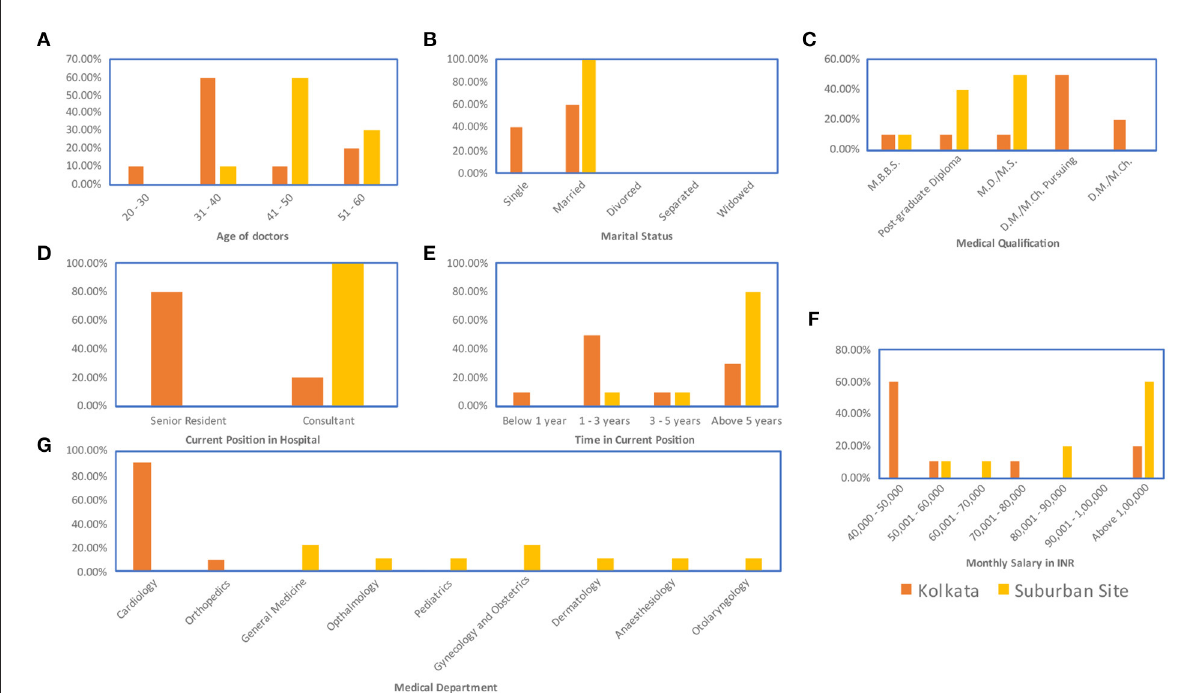
FIGURE1 Demographic data for doctor respondents: (A) Age (B) Marital status (C) Medical qualification. Within the Indian system, medical education is provided at a bachelor’s degree stage, therefore the primary qualification of a practicing doctor in India is Medicine Bachelors and Bachelors